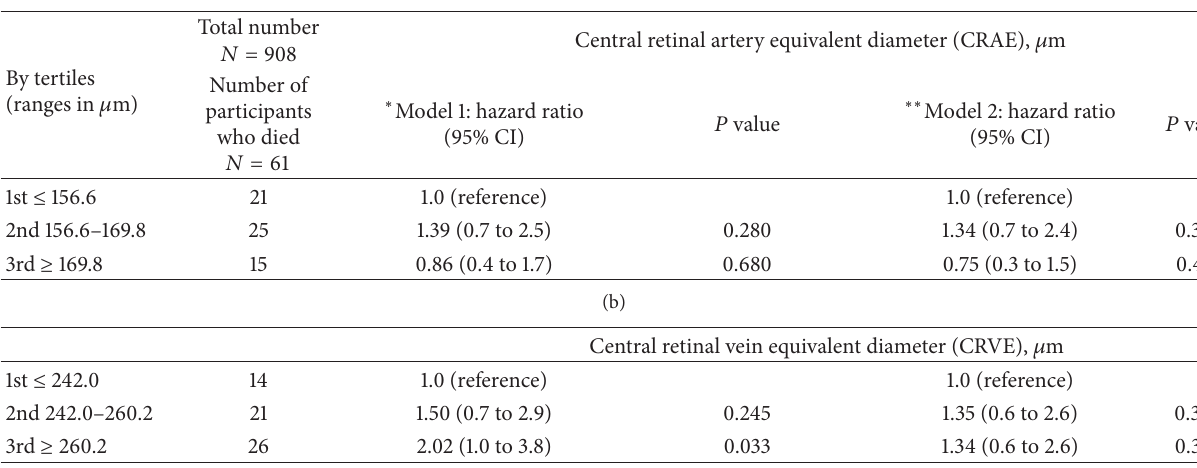
Table 4: Hazard ratios for all-cause mortality in relation to retinal vessel